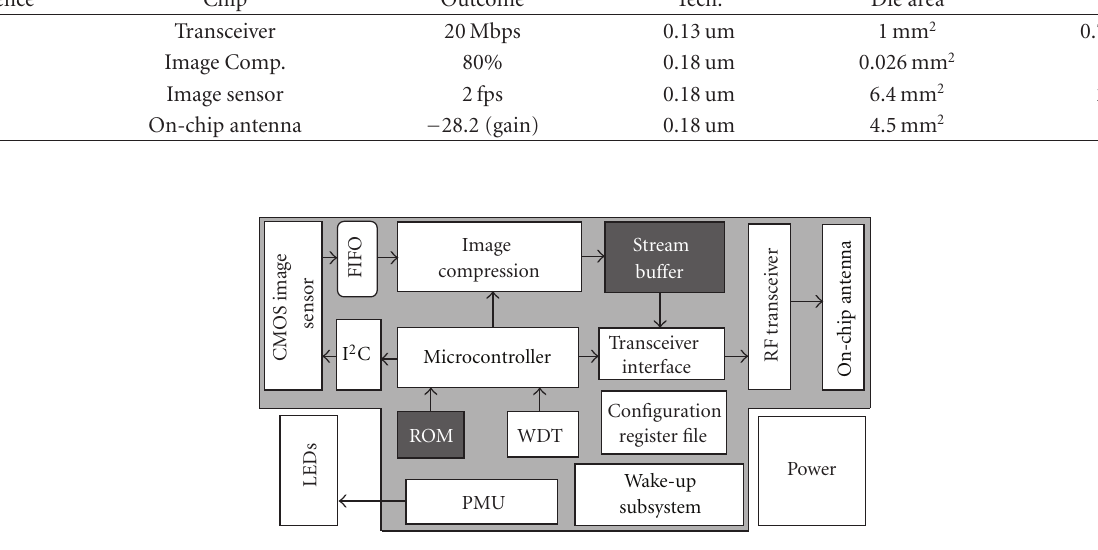
Figure 10: Architecture of mixed-mode, multi-functional ASIC ([62]